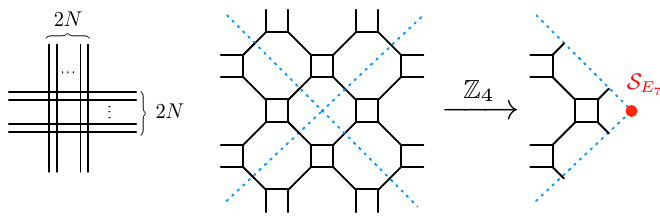
Figure 15 . 5d + 2 N, 2 N -theory and the Z 4 quotient of the + 4 , 4 -theory.